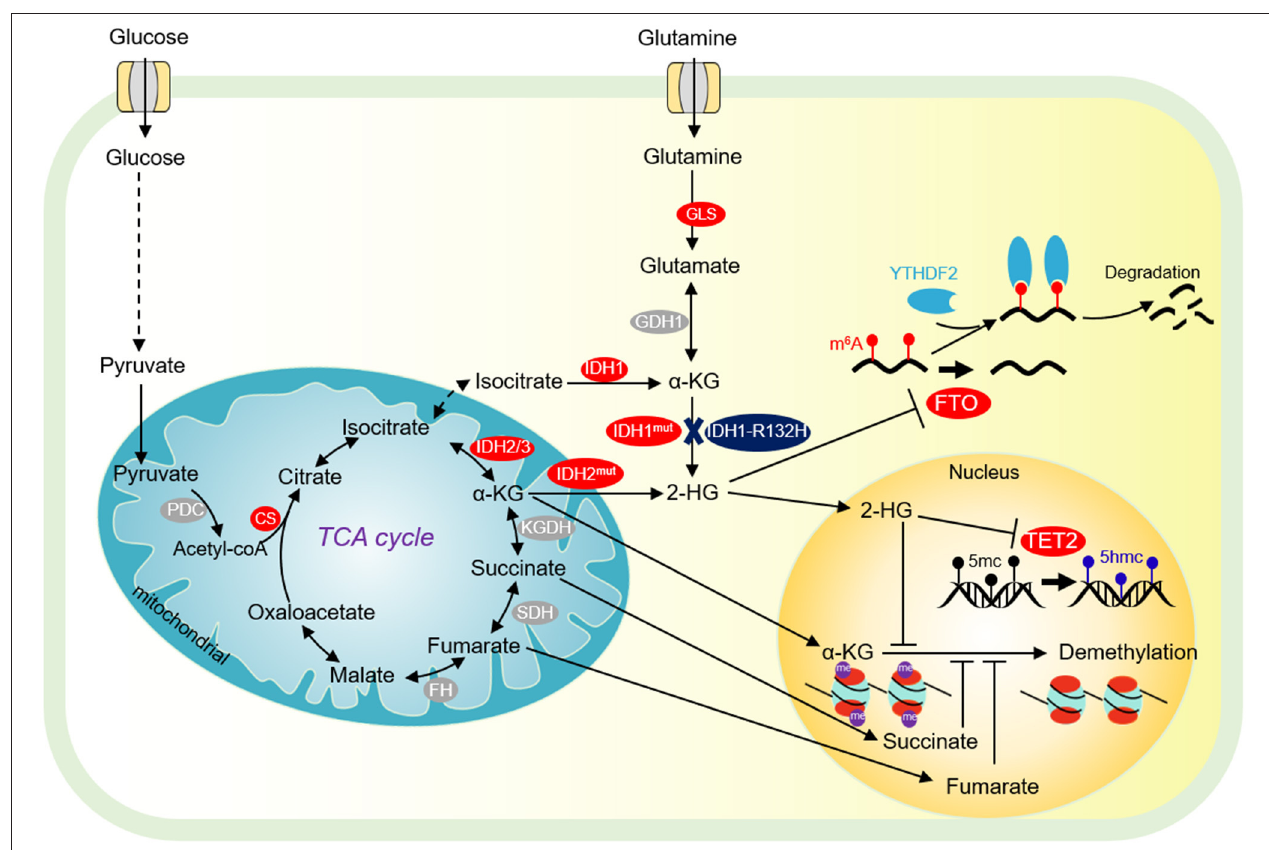
FIGURE 2 | Tricarboxylic acid (TCA) cycle and chromatin demethylation in cancer cells. Although the TCA cycle is repressed in tumor cells, it is also essential for tumor growth. α -KG derived from glucose metabolism or glutamine is essential for tumor cell proliferation and chromatin demethylation. α -KG can be metabolized to succinate and fumarate by FH and SDH in the TCA cycle, respectively. Succinate and fumarate are competitive inhibitors of α -KG dependent demethylases. α -KG can also be converted to 2-HG by mutated isocitrate dehydrogenase 1/2 (IDH1/2). 2-HG is a competitive inhibitor of α -KG-dependent demethylase, which can inhibit DNA methylation mediated by TET2 and JMJD2D, and FTO-mediated m 6 A-dependent mRNA degradation. PDC, pyruvate dehydrogenase complex; CS, citrate synthase; FH, fumarate dehydrogenase; SDH, succinate dehydrogenase; IDH1/2/3, isocitrate dehydrogenase 1 and 2 and 3; Mut IDH1/2, mutated isocitrate dehydrogenase 1 and 2; α -KG, α -ketoglutarate; FTO, fat mass- and obesity-associated; YTHDF2, YTH domain-containing family protein